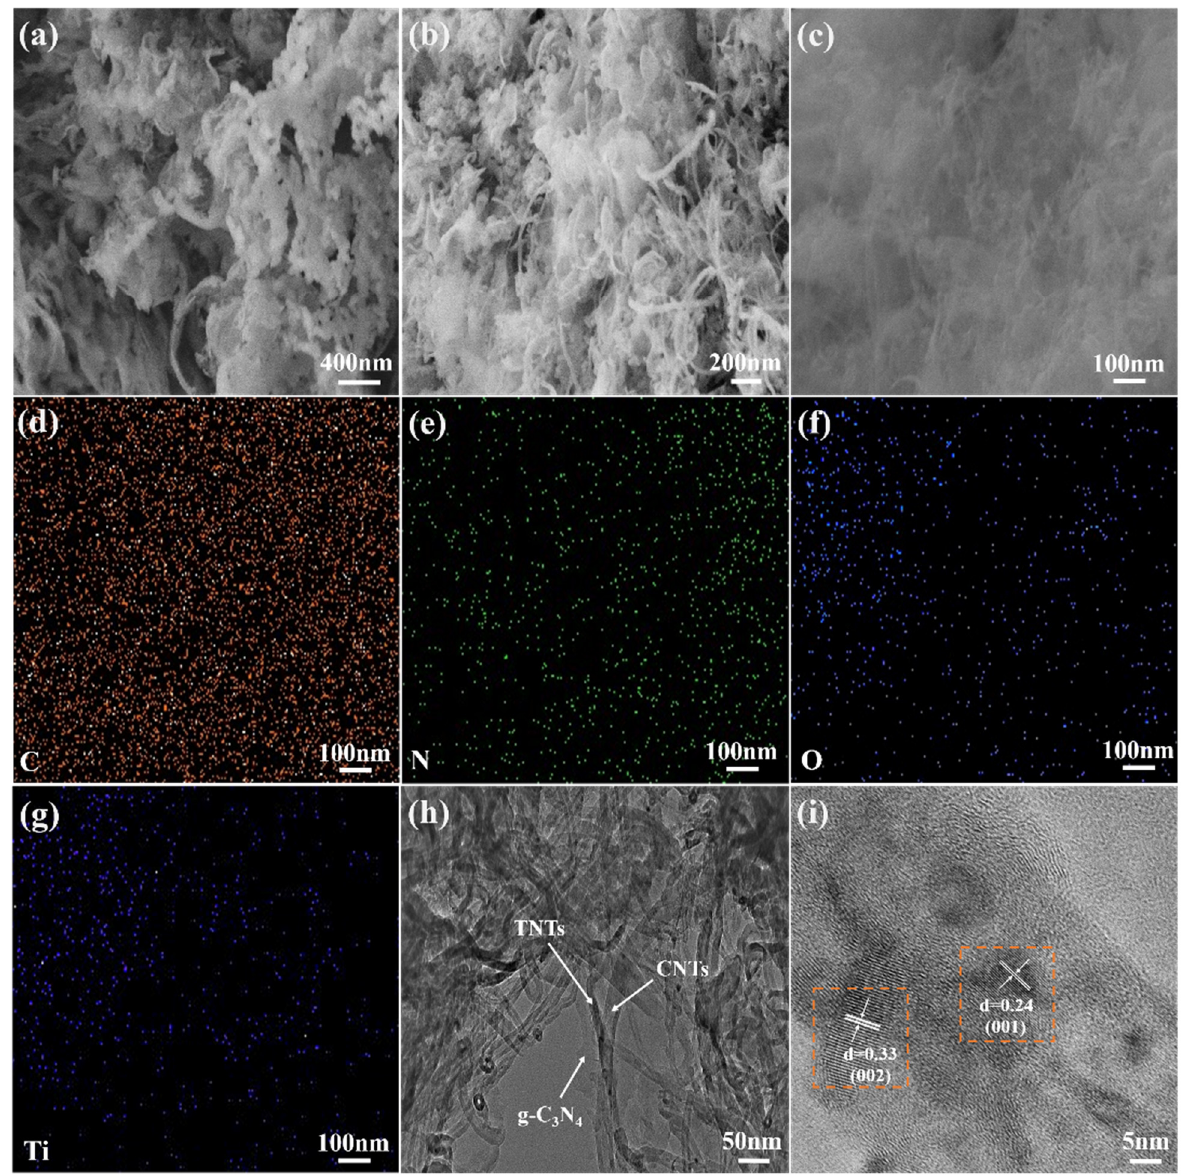
Figure 2. ( a ) SEM image of g-C3N4/TNTs; ( b , c ) SEM image of CNTC-20; ( d – g ) EDS image of CNTC-20; ( h ) TEM image of CNTC-20; ( i ) CNTC-20 of high-resolution TEM images.